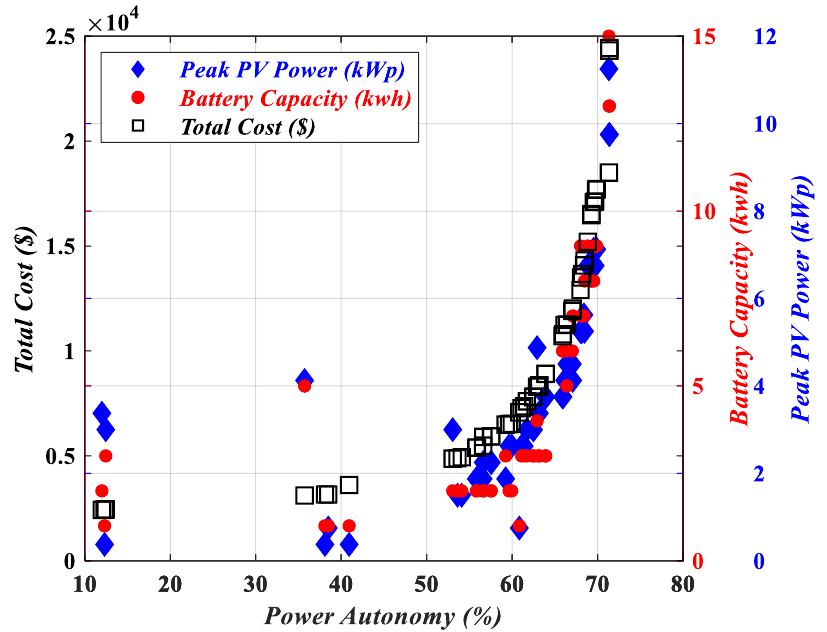
Figure 10. Total cost and power autonomy factor for a variety of PV panel installation areas and battery capacity values for Malaga (residential area).